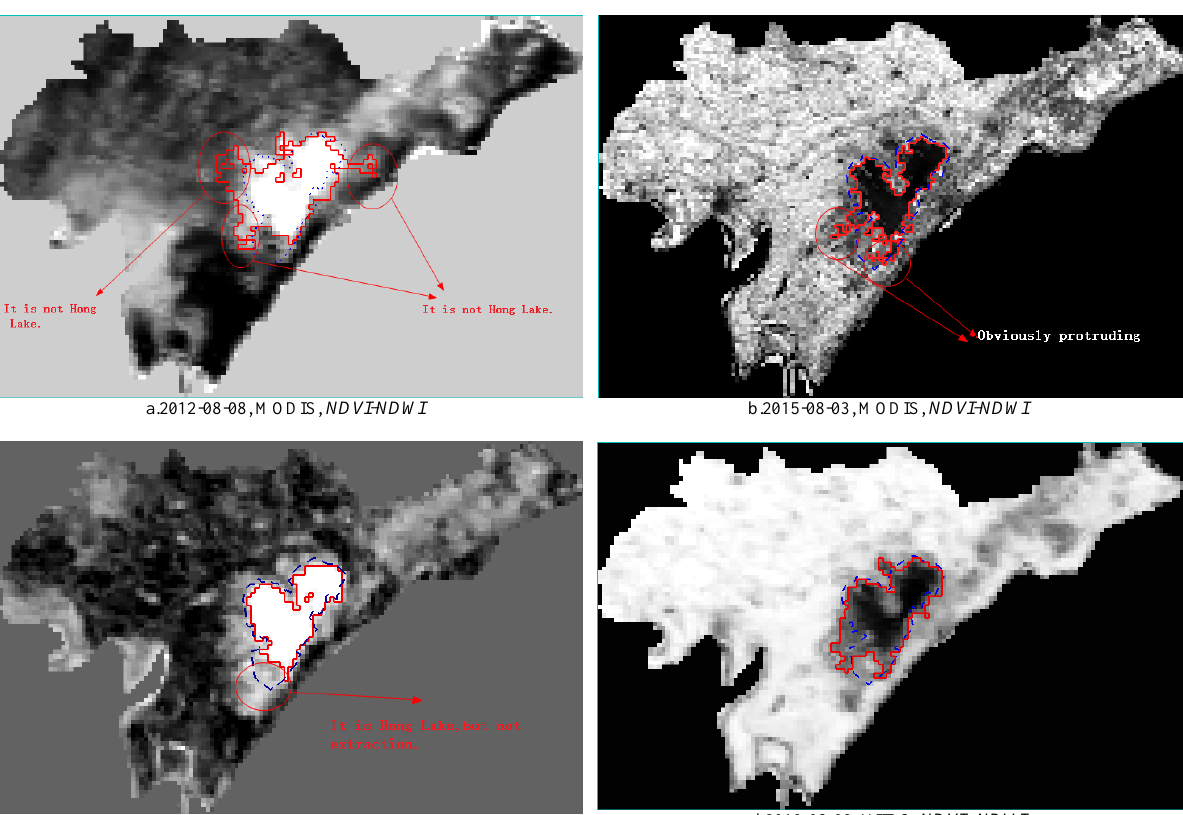
Figure 3. Comparison of VIIRS Images and MODIS Images in Extracting Water.